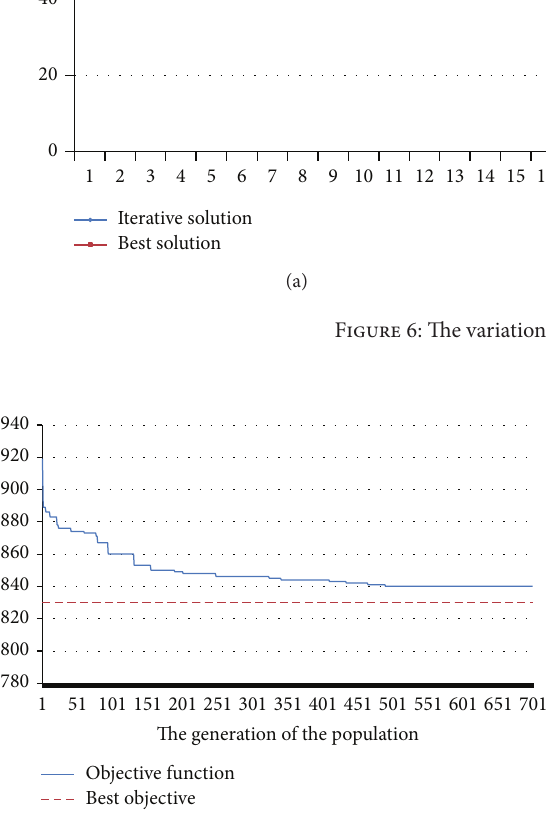
Figure 7: The variation tendency of objective function.